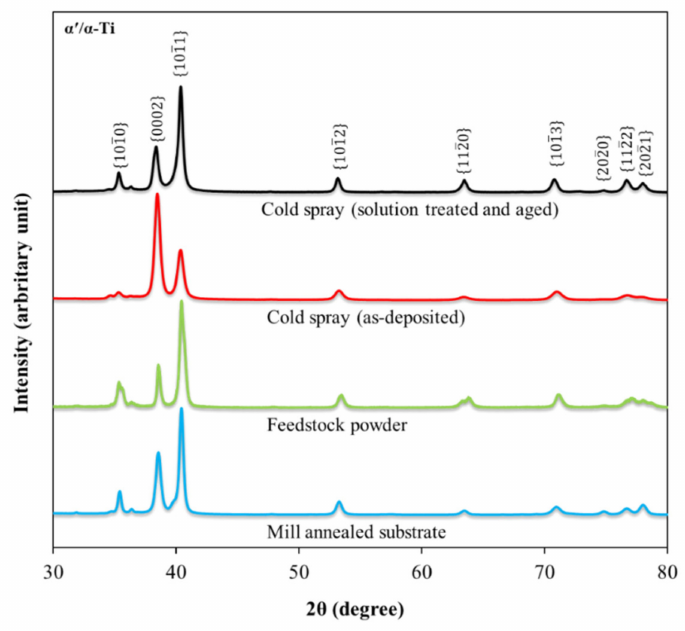
Figure 6. XRD patterns of Ti6Al4V in the sample cross-section covering various materials: mill annealed substrate, feedstock powder, cold spray deposits (as-deposited, solution treated, and aged). The etched cross-sectional microstructures of the coating-substrate interfaces with three different substrate surface preparation conditions are presented in Figure 7, both before and after STA for comparison. In the AD condition, the microstructure of CS deposits is generally comprised of partially deformed ‘textured’ regions and severely de- formed ‘smooth’ regions inherited from the feedstock powder, whereas, the mesostructure is comprised of flattened powder particles that undergone severe plastic deformation with 2.25 ± 0.16% area fraction of porosity. STA led to complete disappearance of the microstructural features of the AD condition through nucleation and growth of recrys- tallized grains, which resulted in coarsened microstructure with equiaxed α grains (dark colored regions) with intergranular vanadium rich β precipitates (light colored regions) as shown in SEM images Figure 7c,f,i. Moreover, STA led to a reduction in porosity to 1.74 ± 0.10% as a result of solid-state densification through atomic thermal diffusion and grain boundary migration at the inter-particle contact interfaces. The same phenomenon also brings significant growth in metallurgical bonding via enhanced long-range diffusion at a higher temperature [13]. Nevertheless, remnants from grit-blasted particles can be seen in the interface for grit basted surfaces as can be observed in Figure 7a–c. In Figure 7h,i, the grain size of the ground substrate material appears to be smaller, although CS deposition process parameters and STA parameters were the same for all specimens. Therefore, it might be the case that substrate material (i.e., the ‘Collar’ part of CPP specimen) used for ground specimens came from a different batch of Ti6Al4V round bar or from different ends/regions of the same bar where the microstructure was slightly